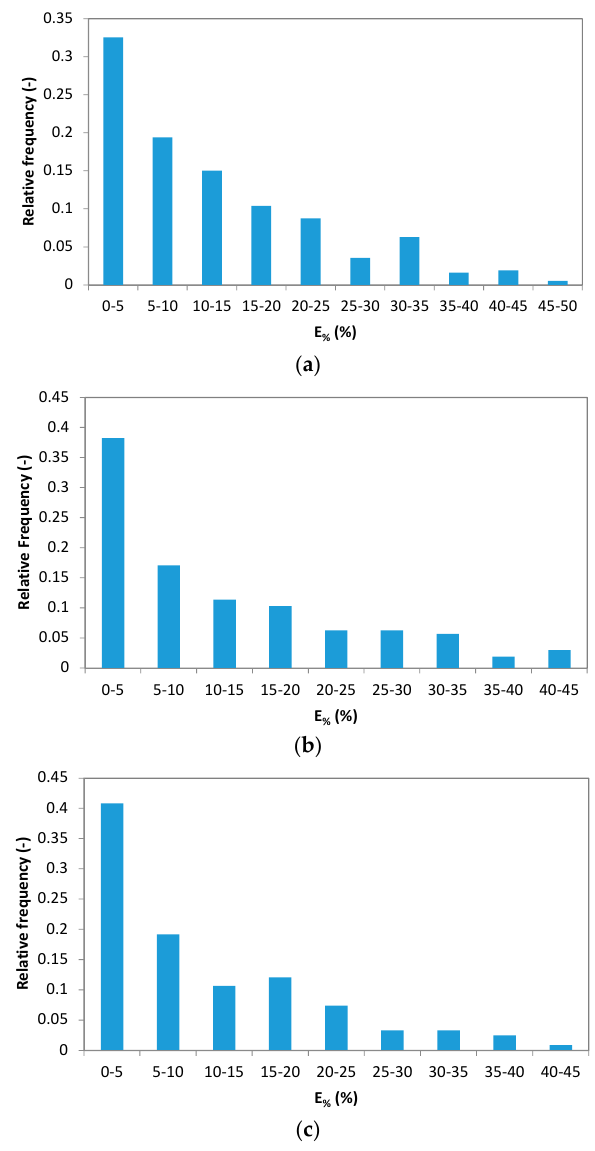
Figure 6. Relative frequency of the underestimation error, E % , of the maximum rainfall depths considering classes’ amplitude equal to 5%. ( a ) t a = d = 30 min, ( b ) t a = d = 60 min, and ( c ) t a = d = 1440 min. All selected rain gauge stations were considered.